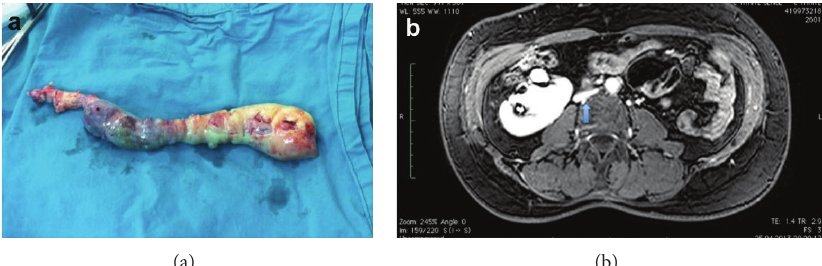
Figure 2: (a) View of the excised mass, (b) magnetic resonance venography of the patient at postoperative period (a relative collapse arrowed, depending on extraction of huge